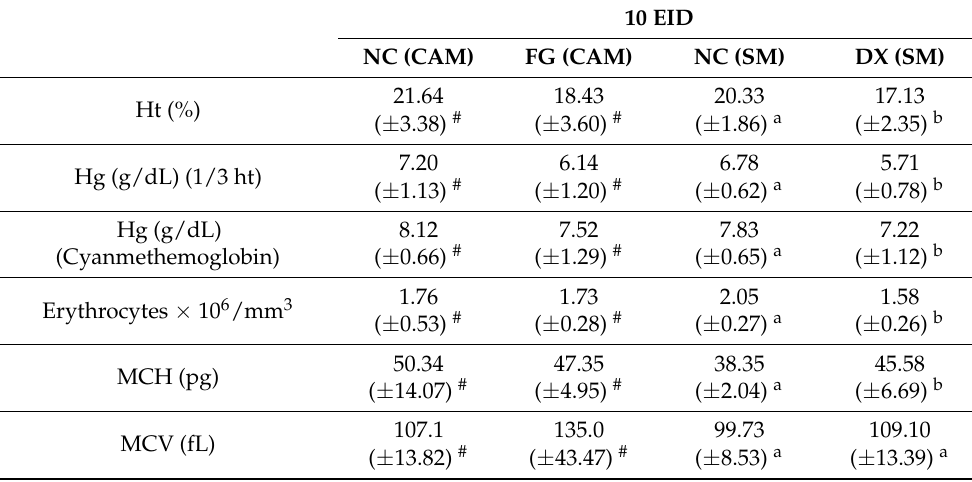
Table 5. Blood cell count in CE treated with FG and DX at 10